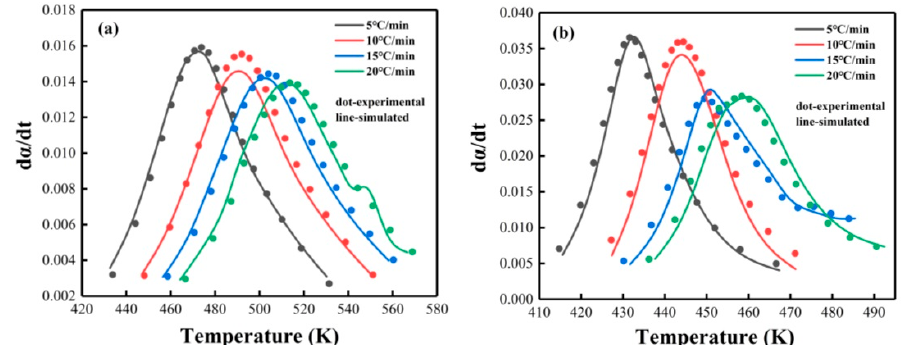
Figure 9. The comparison between experimental and simulated DSC curves of ( a ) PNE-177/DDS and ( b ) PNE-177/DICY systems based on SB (m, n) model.